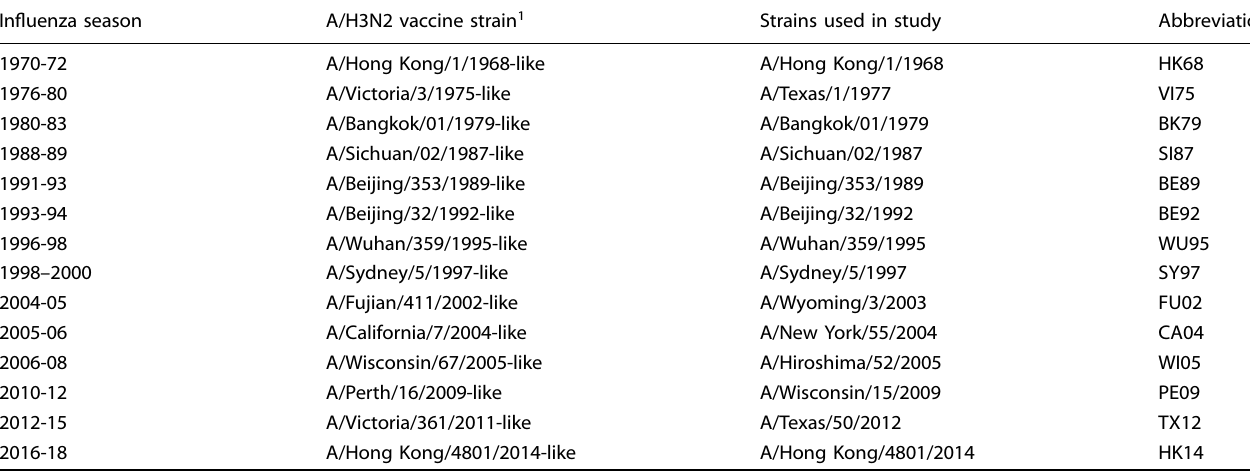
Table 1. The 14 genetically and antigenically distinct in fl uenza A/H3N2 viruses used in the study. In fl uenza